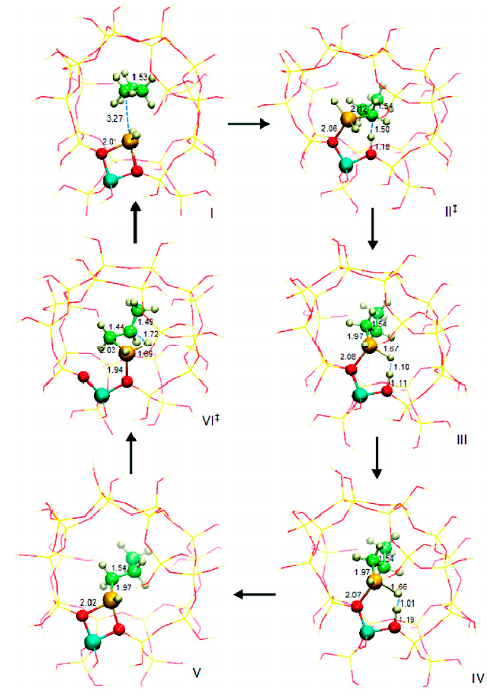
Figure 18. Dehydrogenation reaction of ethane through the three-step mechanism computed with GaH 2 species and T22 cluster (B3LYP/6-31G**). Reprinted with permission from ref [133]. Copyright 2008 American Chemical Society.